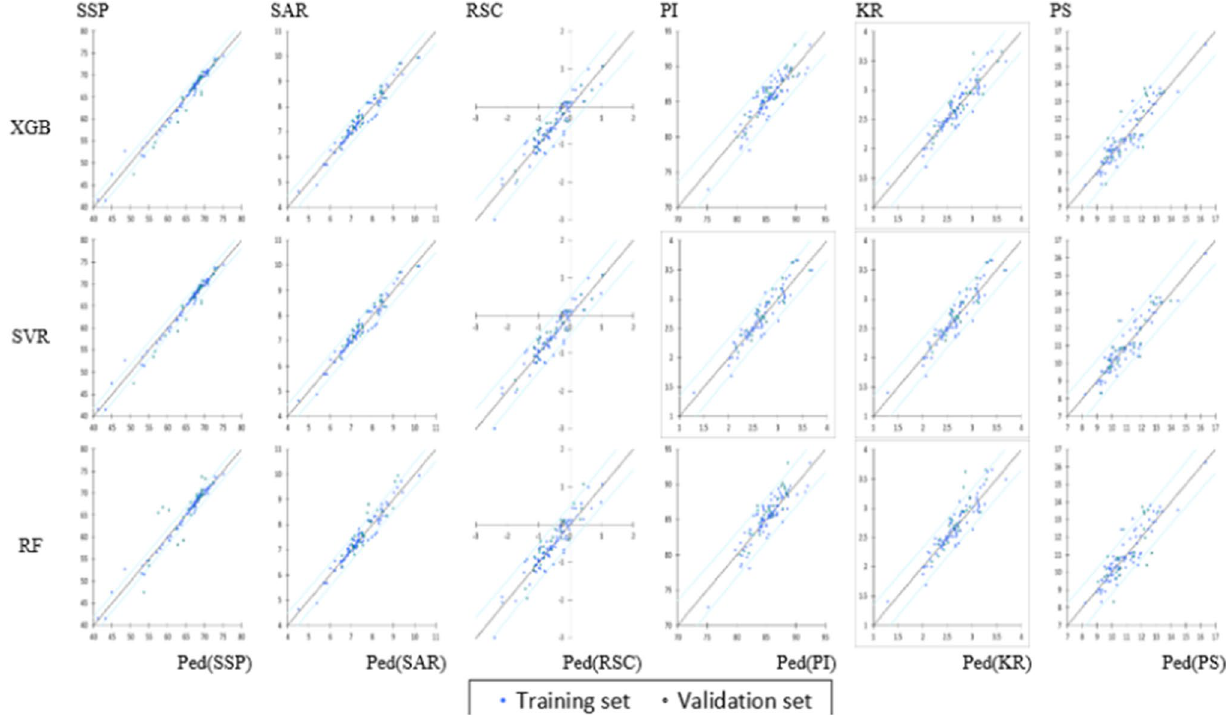
Fig. 5 Scatterplots of the estimated and calculated values of the IWQIs for the applied models (XGB, SVR and